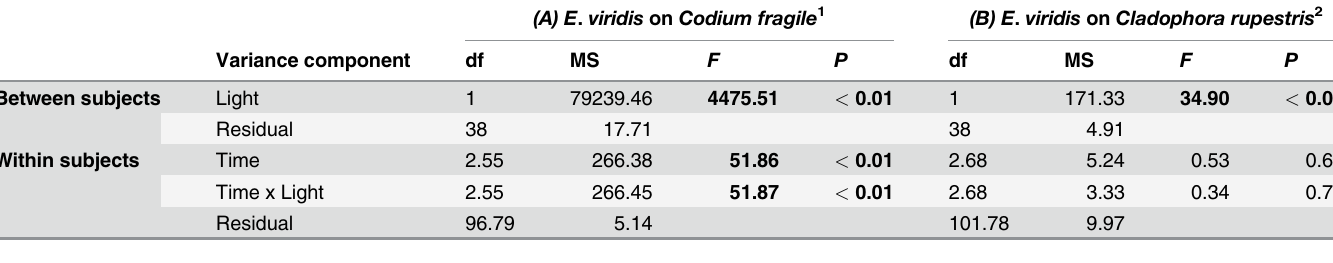
Table 1. Repeated measures analysis of variance of the relative electron transport rate (rETR) of Elysia viridis consuming Codium fragile A) and Cladophora rupestris B) under low and high light (Light) during a four-week experiment